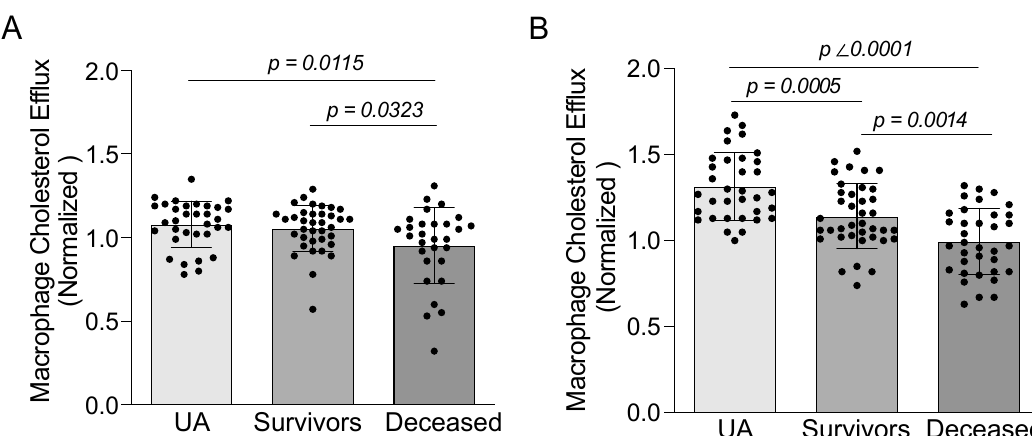
Figure 1. Macrophage cholesterol efflux is impaired in STEMI patients who died within a two-year follow-up period under baseline conditions (ANOVA p value = 0.0096) ( A ) and after activation of macrophage ABCA1/G1-dependent pathways by the LXR agonist, T090137 (ANOVA p value < 0.0001) ( B ). Values are represented as mean ± SD for UA ( n = 33), STEMI survivors ( n = 36) and deceased STEMI ( n = 35).